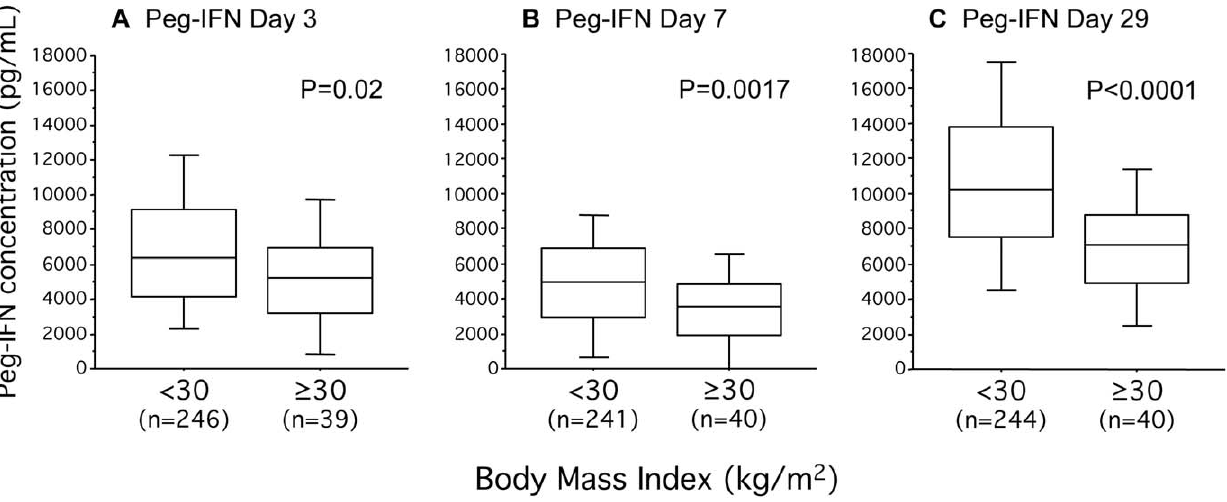
Figure 2. Impact of obesity on interferon concentrations. Box plots displaying the 10 th , 25 th , 50 th , 75 th , and 90 th percentiles of the plasma concentrations of peginterferon (pg/mL) treatment day 3, 7, and 29 ( A–C respectively). P-values obtained using Mann-Whitney U-test.